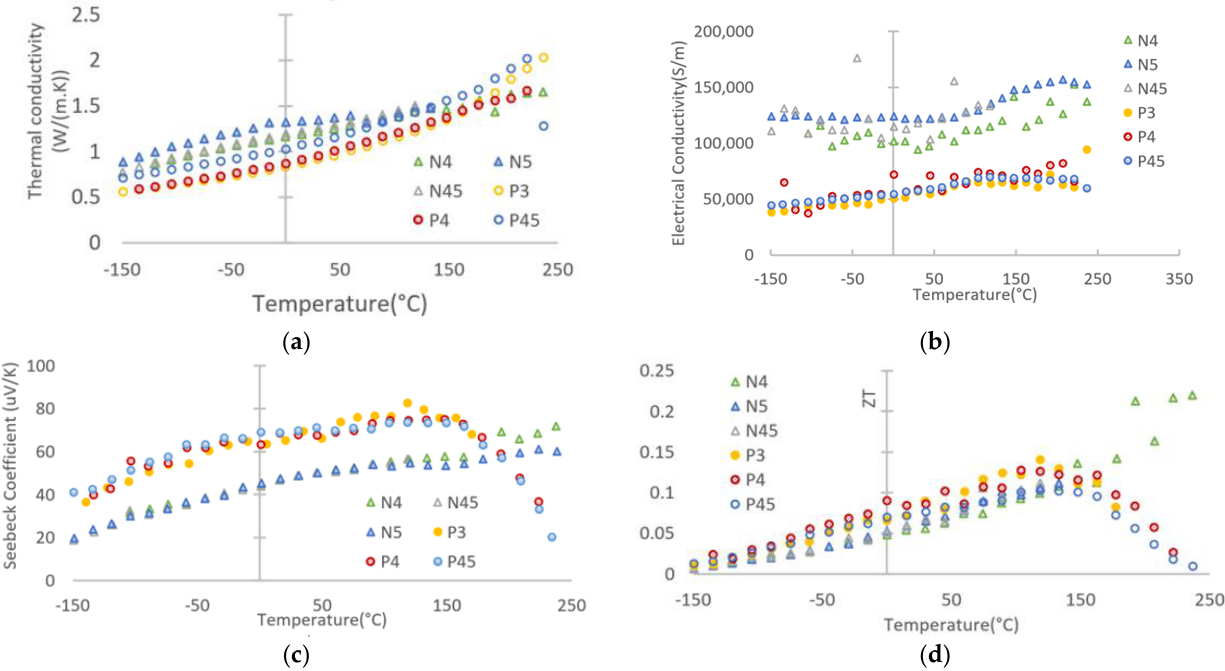
Figure 7. Thermal electric property measurements of the N-type and P-type thin films within the temperature range − 150 °C to 230 °C: ( a ) thermal conductivity; ( b ) electrical conductivity; ( c ) absolute value change of Seebeck coefficient; and ( d ) calculated ZT value.